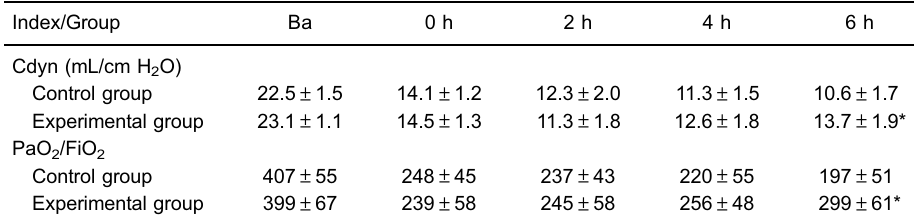
Table 1. Dynamic lung compliance (Cdyn) and oxygenation index (PaO 2 /FiO 2 ) of male pigs induced with acute respiratory distress syndrome that received continuous veno-venous hemo fi ltration therapy (experimental) or conventional supportive therapy